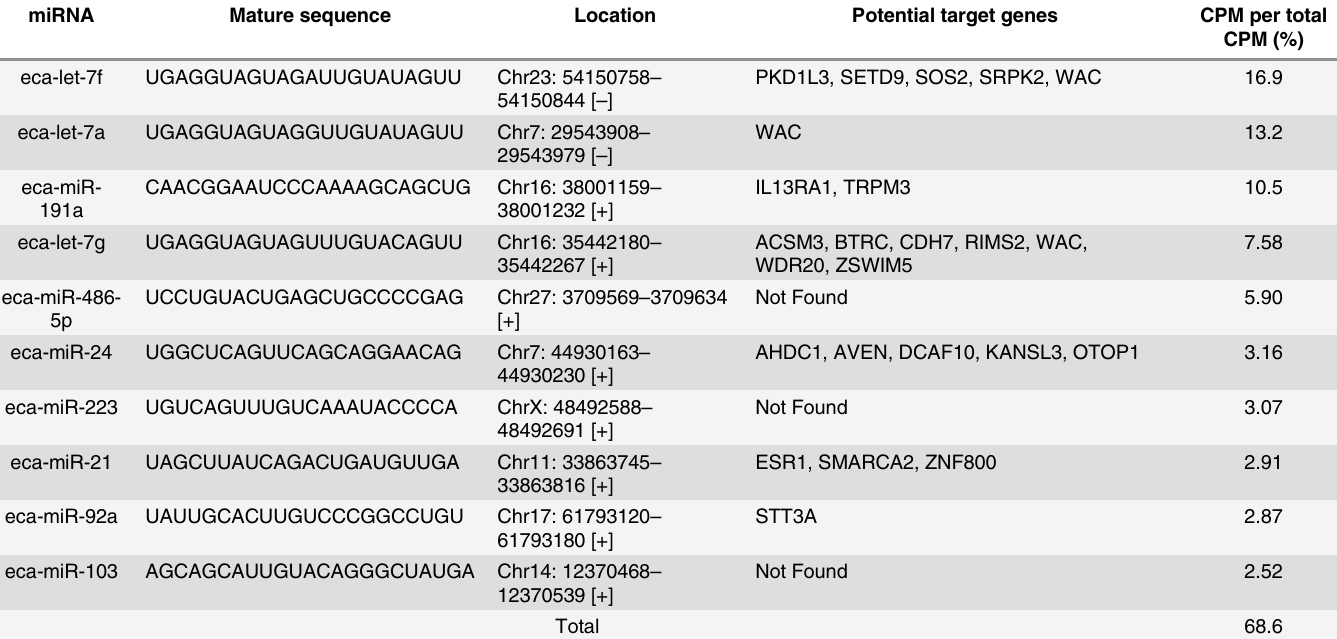
Table 2. Ten most abundant miRNA species in horse plasma. Location represents the chromosome on which the miRNA genes are located, start and end sites, and either sense [+] or antisense strand [ − ]. miRNA Mature